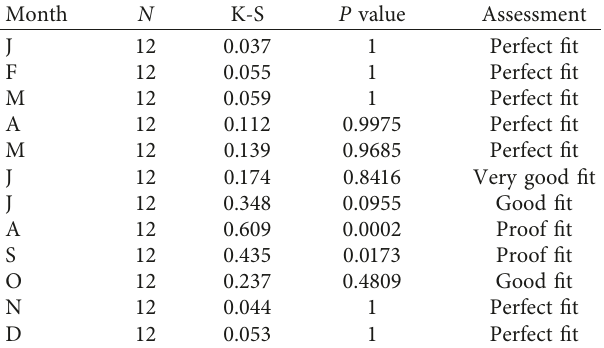
Table 7: Results of the K-S test for the daily